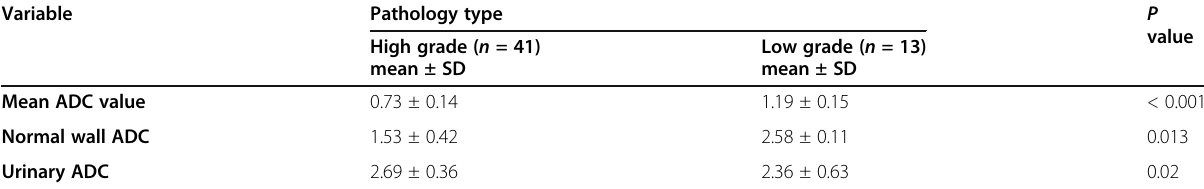
Table 4 Mean ADC values according to tumor grades